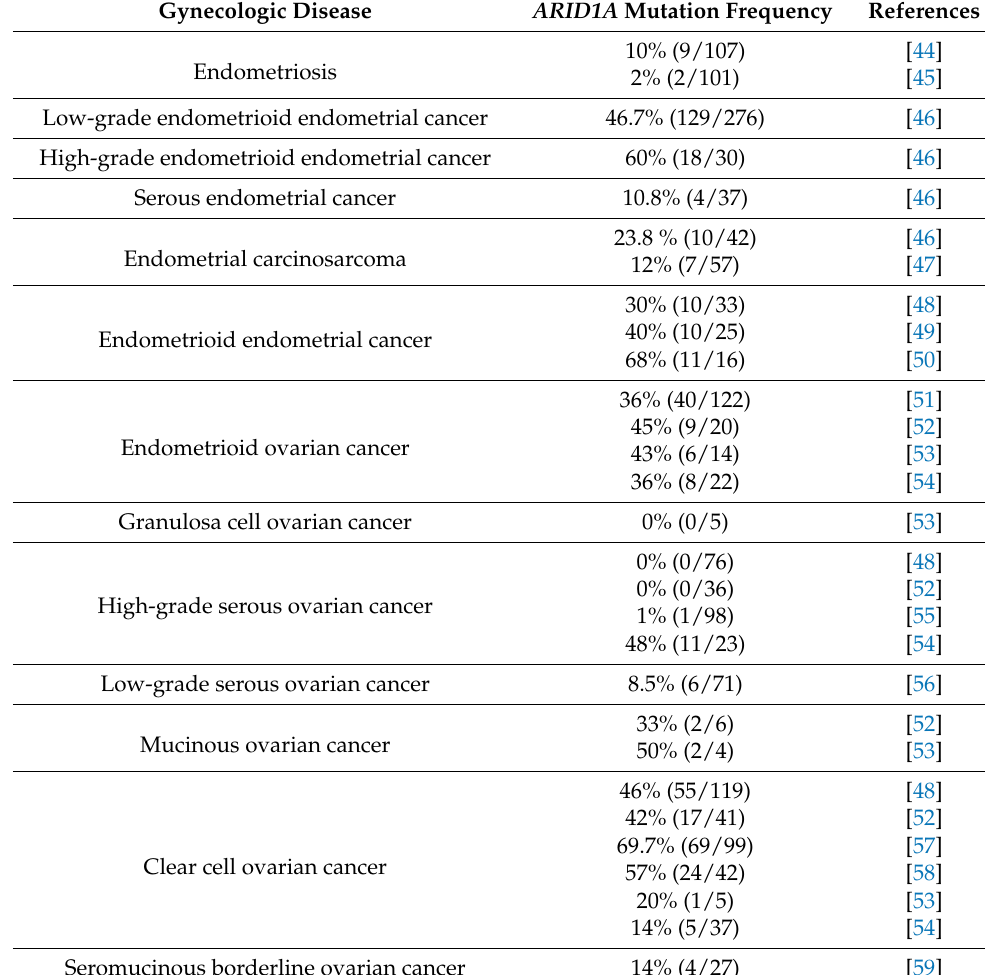
Table 2. ARID1A mutation frequency in gynecologic